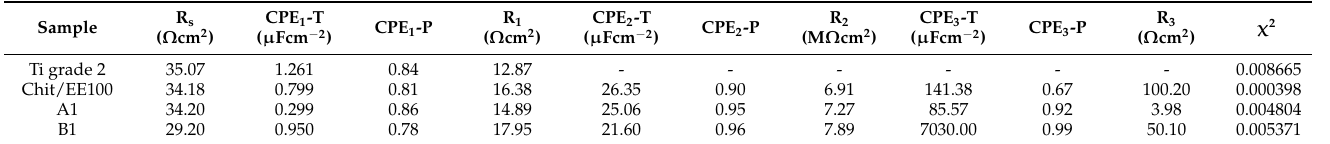
Table 6. Simulated parameters of EIS data using the proposed equivalent circuits for the investigated samples. Sample